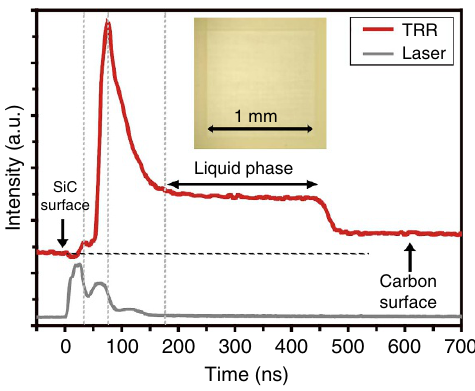
Figure 3 | TRR signal of 4H-SiC surface with single-pulse irradiation. TRR method is used to prove melt-mediated phase transformation by using different reflectances of the solid and liquid phases. The red line indicates reflectance trace of 4H-SiC surface before and after single-pulse irradiation. The grey line presents laser intensity as a function of time and the inset shows an optical microscope image of the laser irradiated surface, 1 (cid:3) 1mm 2